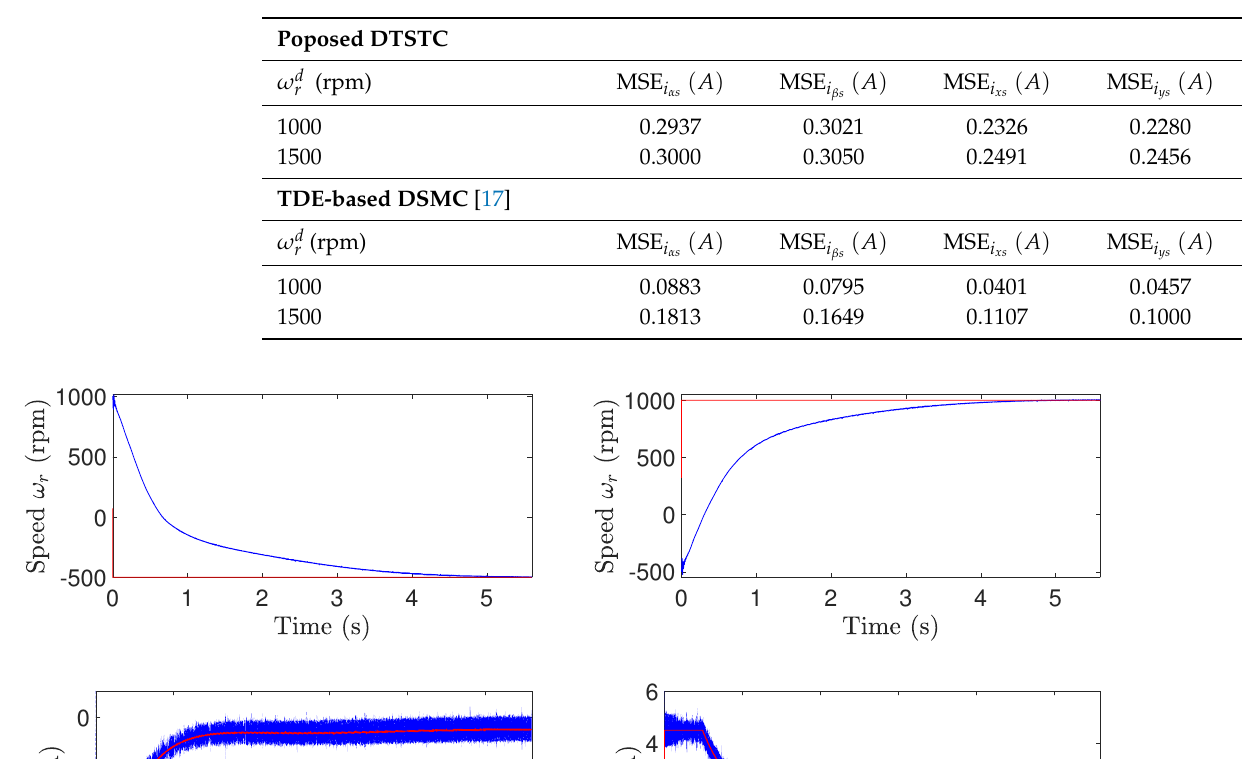
Table 2. Quantitative comparison of the MSE of the { α , β , x , y } stator currents performance for two different rotor speed references.